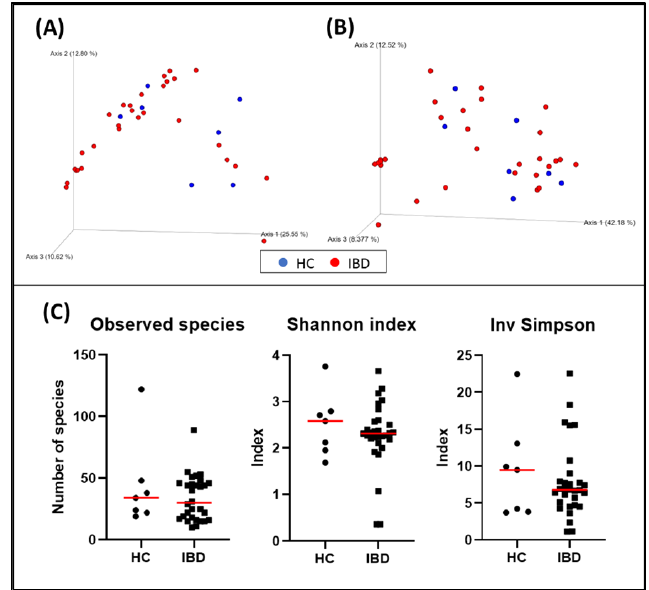
Figure 1. Bacterial diversity measures of duodenal samples: The dimensional representation of principal coordinate analysis (PCoA) plots of ( A ) unweighted and ( B ) weighted UniFrac distances of 16S rRNA genes. Duodenal biopsy specimens from dogs with IBD were not separated from those obtained from healthy dogs (PERMANOVA, p = 0.358; pseudo – F: 1.07). ( C ) Comparisons of α–diversity: observed species ( p = 0.600), Shannon index ( p = 0.684), and inverse Simpson index ( p = 0.742). Red lines represent the median for each measure. HC, healthy control dogs; IBD, inflammatory bowel disease dogs.